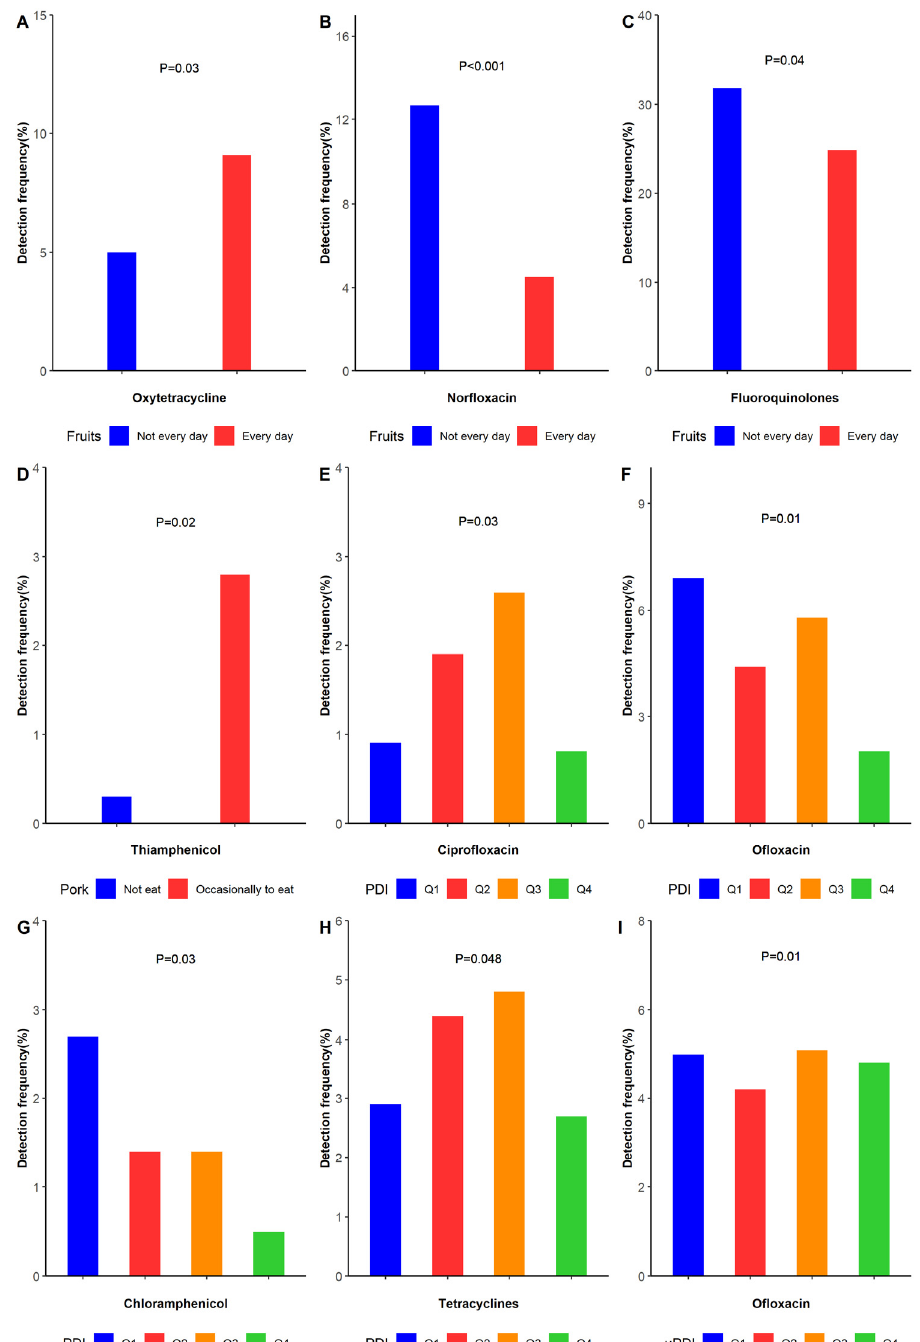
Figure 1. The rate of detection of antibiotics in urine was related to selected dietary characteristics. (The results in Figure 1 are based on the positive results in Table S1). ( A ) Eating fruits every day and not every day in the detection frequency of oxytetracycline. ( B ) Eating fruits every day and not every day in the detection frequency of norfloxacin. ( C ) Eating fruits every day and not every day in the detection frequency of fluoroquinolones. ( D ) Eating pork occasionally and not eating pork in the detection frequency of thiamphenicol. ( E ) Detection frequency of four groups of PDI in ciprofloxacin. ( F ) Detection frequency of four groups of PDI in ofloxacin ( G ) Detection frequency of four groups of PDI in chloramphenicol. ( H ). Detection frequency of four groups of PDI in tetracyclines. ( I ) Detection frequency of four groups of uPDI in